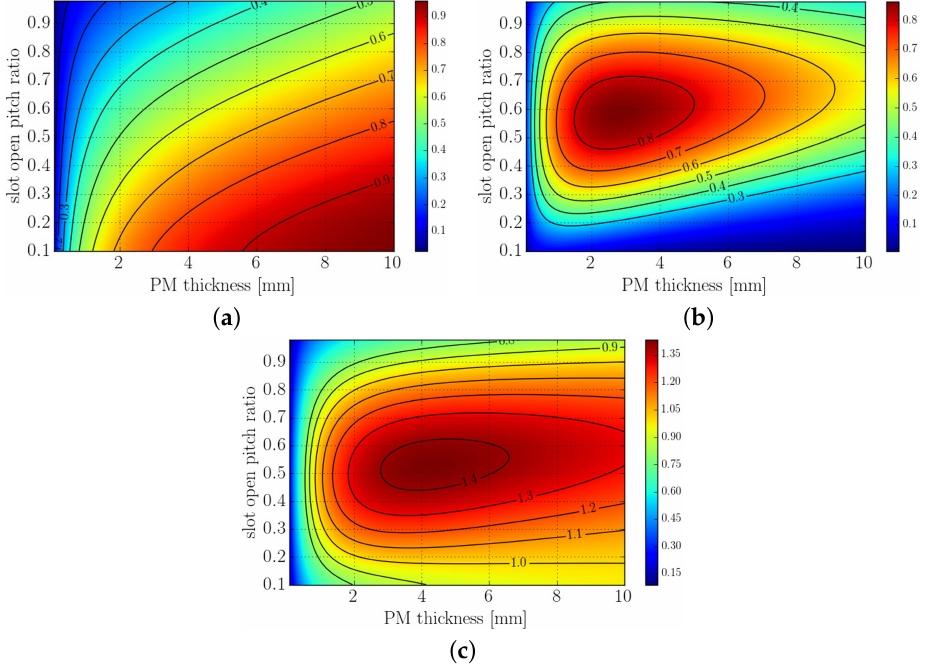
Figure 3. Variation of Equation (5) components as a function of PM thickness and slot opening ratio: ( a ) K conv , ( b ) K add , ( c ) K vern = K conv + K add